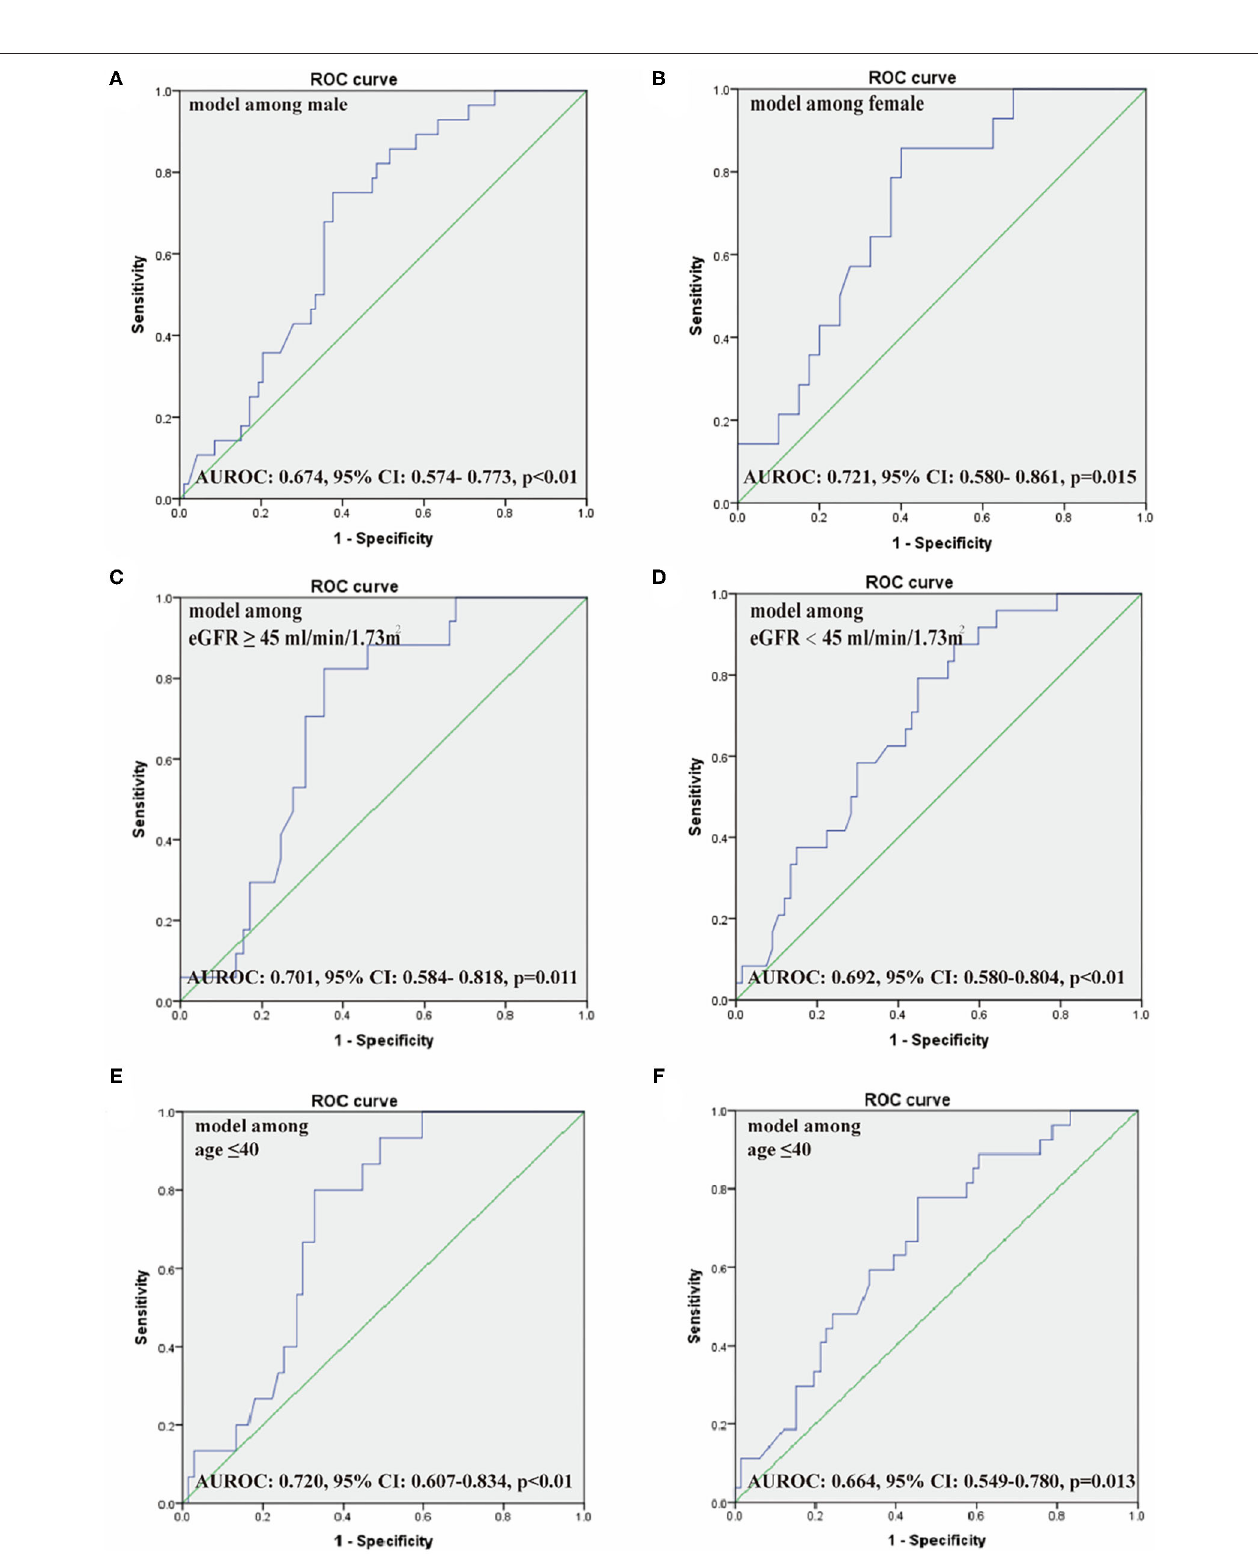
FIGURE 3 | The ROC of our model among male (A) and female patients (B) , eGFR ≥ 45 ml/min/1.73 m 2 (C) and < 45 ml/min/1.73 m 2 (D) , age ≤ 40 years (E) and > 40 years (F) . AUROC, the area under the receiver operating characteristic curve.